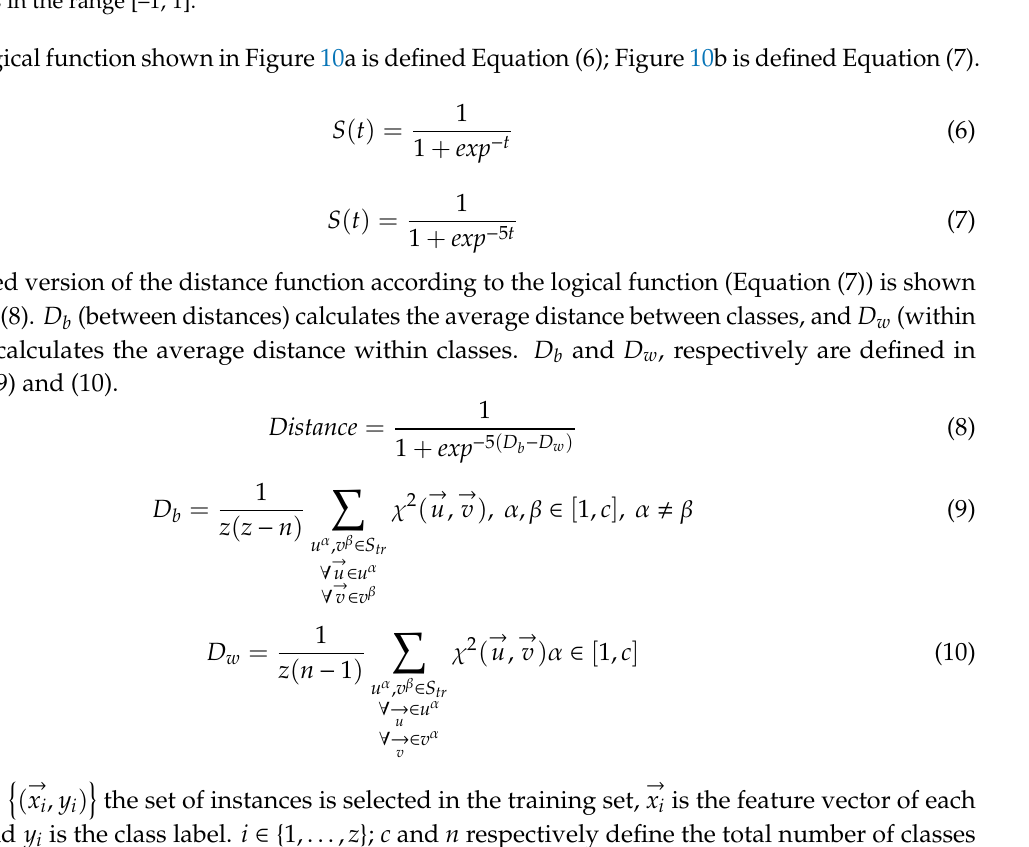
Figure 10. Logical Functions; ( a ): logical function range is in the range [–5, 5], ( b ): logical function range is in the range [–1, 1].